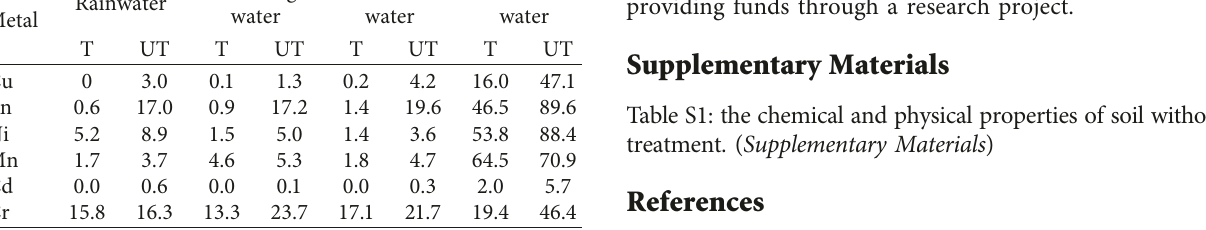
Table 1: Percentage of heavy metals leaching from soil samples. Rainwater Metal